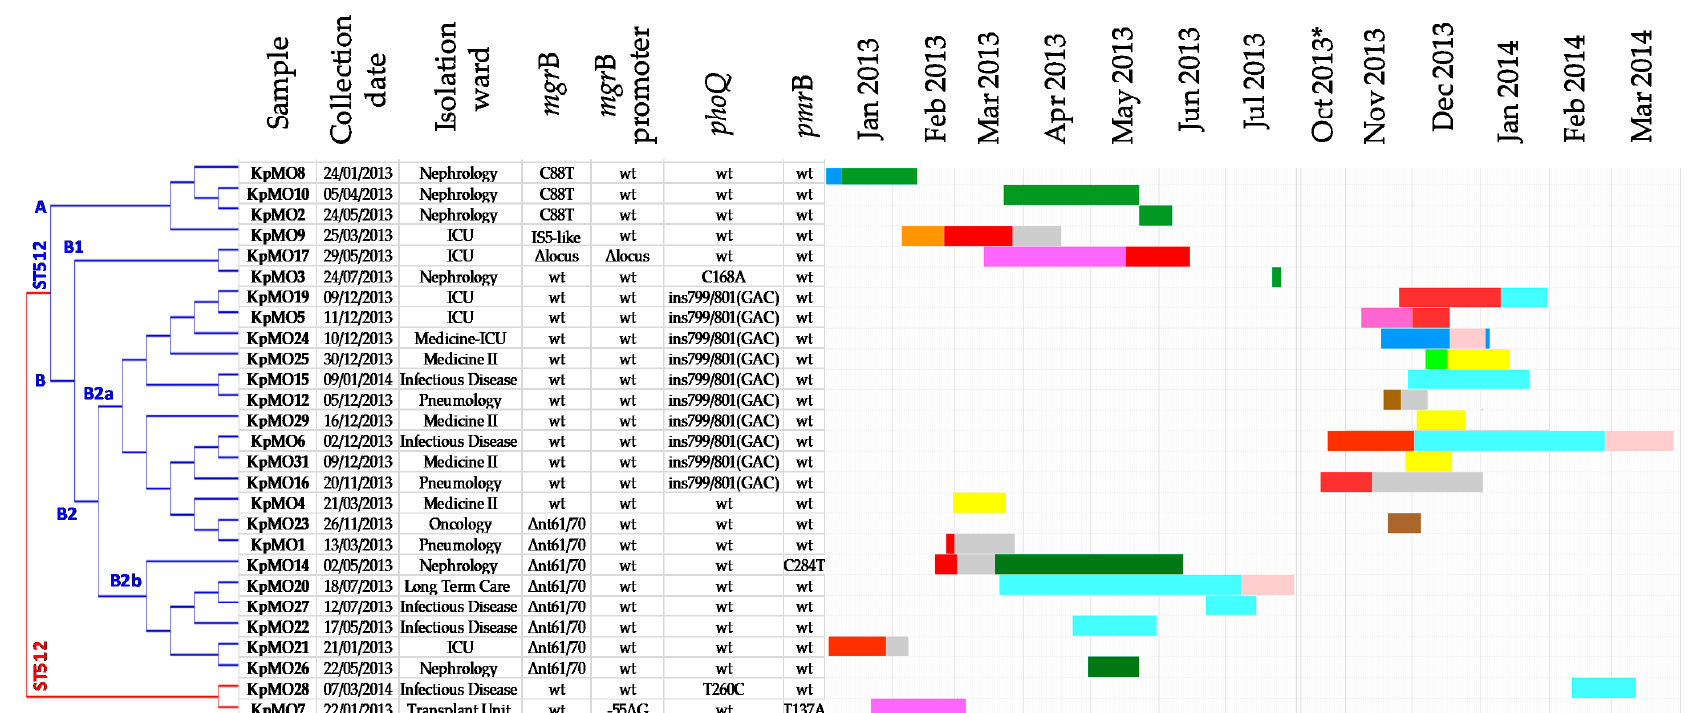
Figure 3. Core SNPs analysis data incorporated into the epidemiological metadata. Core SNPs tree (left) shows two major lineages corresponding to the ST512 (blue) and the ST258 (red). Clusters within ST512 lineage are indicated by capital letters (A, B) followed by a number in the minor branches (B1, B2) and by additional lowercase letters in the subgroups (B2a, B2b). The right box represents patients’ movements inside the hospital, each color represents a ward. ICU, red; Infectious Disease, cyan, Long Term Care, pink; Medicine II, yellow; Medicine ICU, blue; Nephrology, dark green; Oncology, brown; Orthopedics, light green; Otolaryngology, orange; Pneumology, grey; Transplant Unit, fuchsia. ICU, Intensive Care Unit; ∆ , deletion; IS, Insertion Sequence; ins, insertion; wt, wild type. * days 15-31